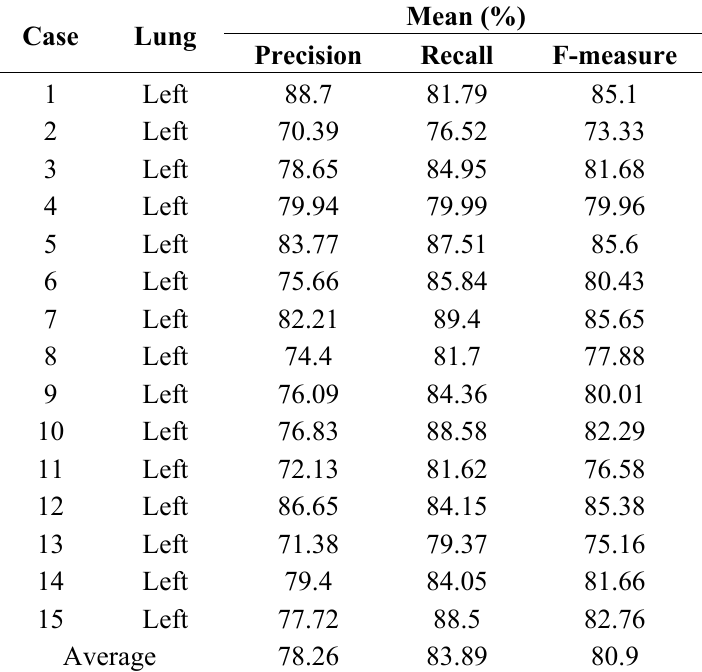
Table 2. The experimental results of precision, recall and F-measure by the proposed ACO method for 15 left lung cases.